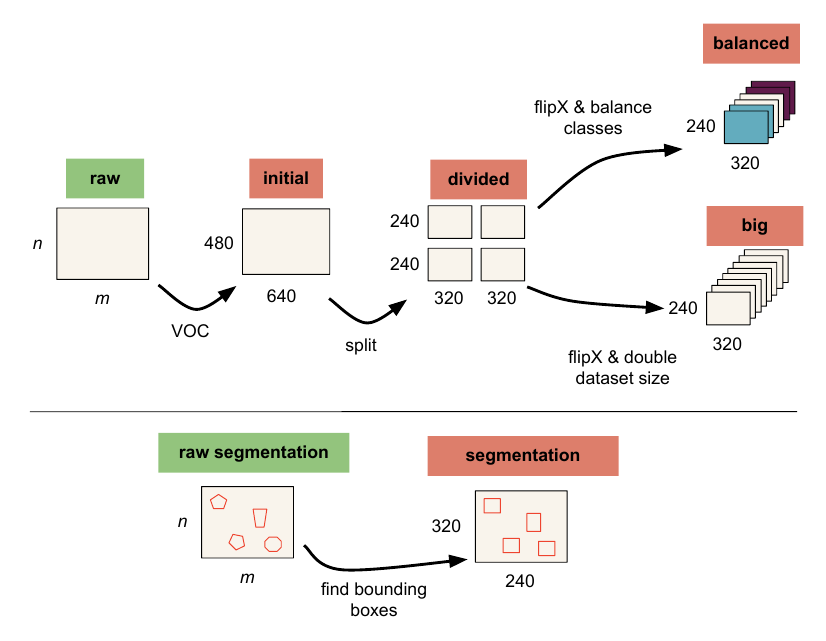
Figure 4. Overview of the datasets relationship.